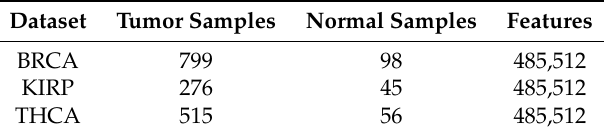
Table 1. Compact overview of the datasets.